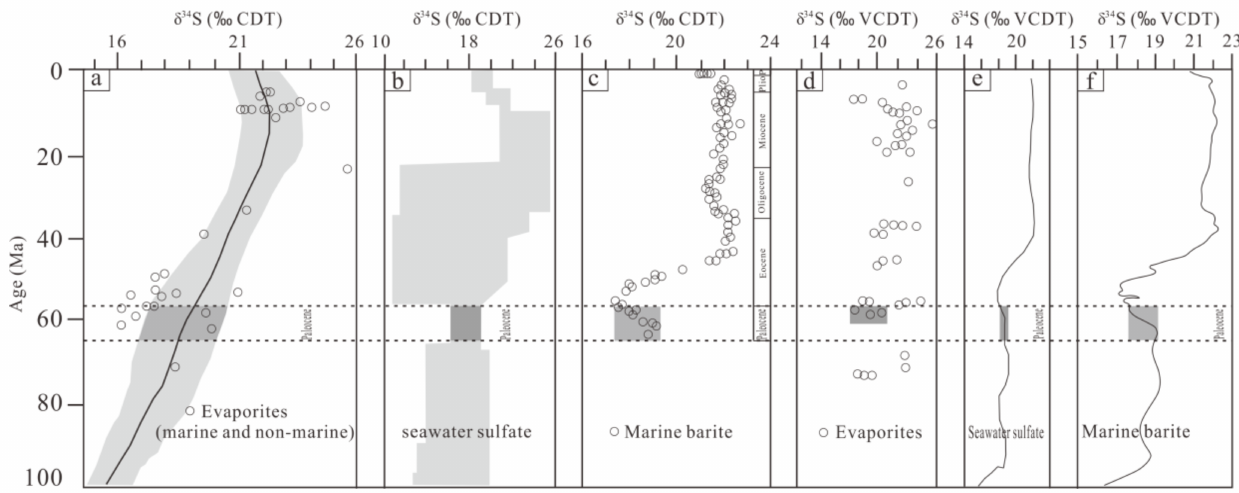
Figure 3. Sulfur isotopic variations of seawater sulfate in the Paleocene. ( a ) The values of δ 34 S CDT range about from 17.2‰–20.4‰ [9]; ( b ) The values of δ 34 S CDT range about from 16.2‰–19.1‰ [3]; ( c ) The values of δ 34 S CDT range about from 17.4‰–19.3‰ [5]; ( d ) The values of δ 34 S VCDT range from about 17.0‰–21.0‰ [12]; ( e ) The values of δ 34 S VCDT range about from 18.1‰–19.1‰ [11]; ( f ) The values of δ 34 S VCDT range about from 17.34‰ ± 0.2–19.11 ± 0.3‰